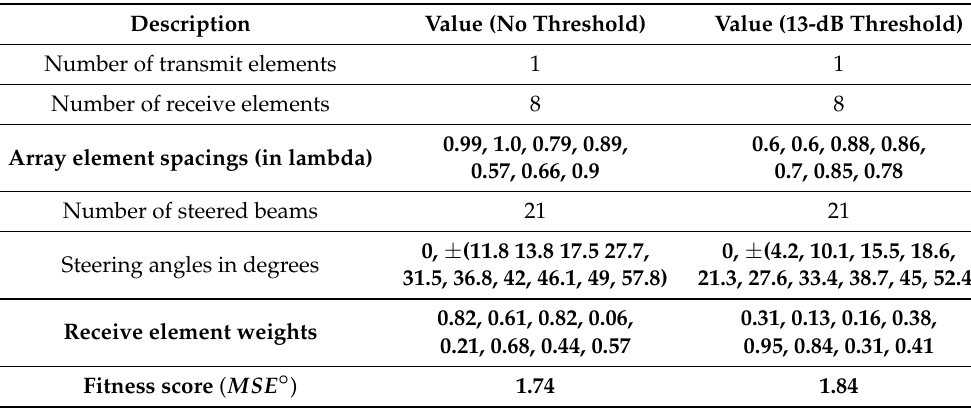
Table 11. Experiment 5